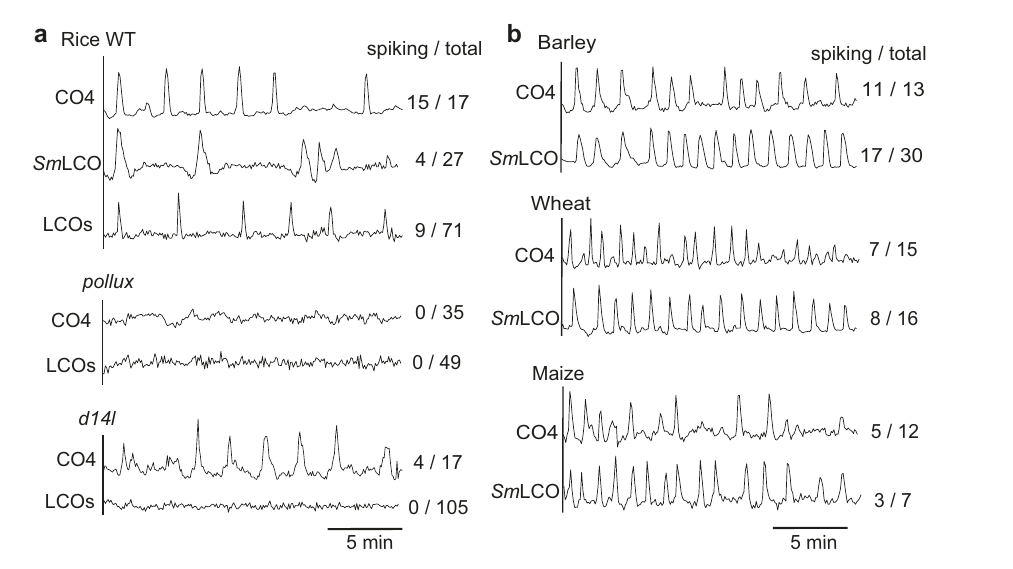
Fig. 2 | COs and LCOs activate calcium oscillations in cereals. a Representative traces of atrichoblasts from lateral roots in rice wild type (WT), pollux and d14l mutants responding to 10 − 5 M CO4, 10 − 7 M Sm LCO and LCOs (1:1 mix of 10 − 7 M sulfated-LCOand10 − 7 MNS-LCO). b Representativecalciumtracesofbarley,wheat,